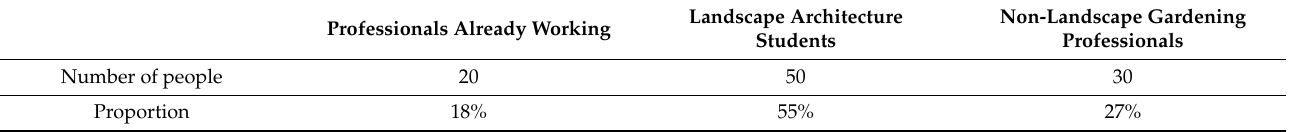
Table 2. Distribution of Respondents.